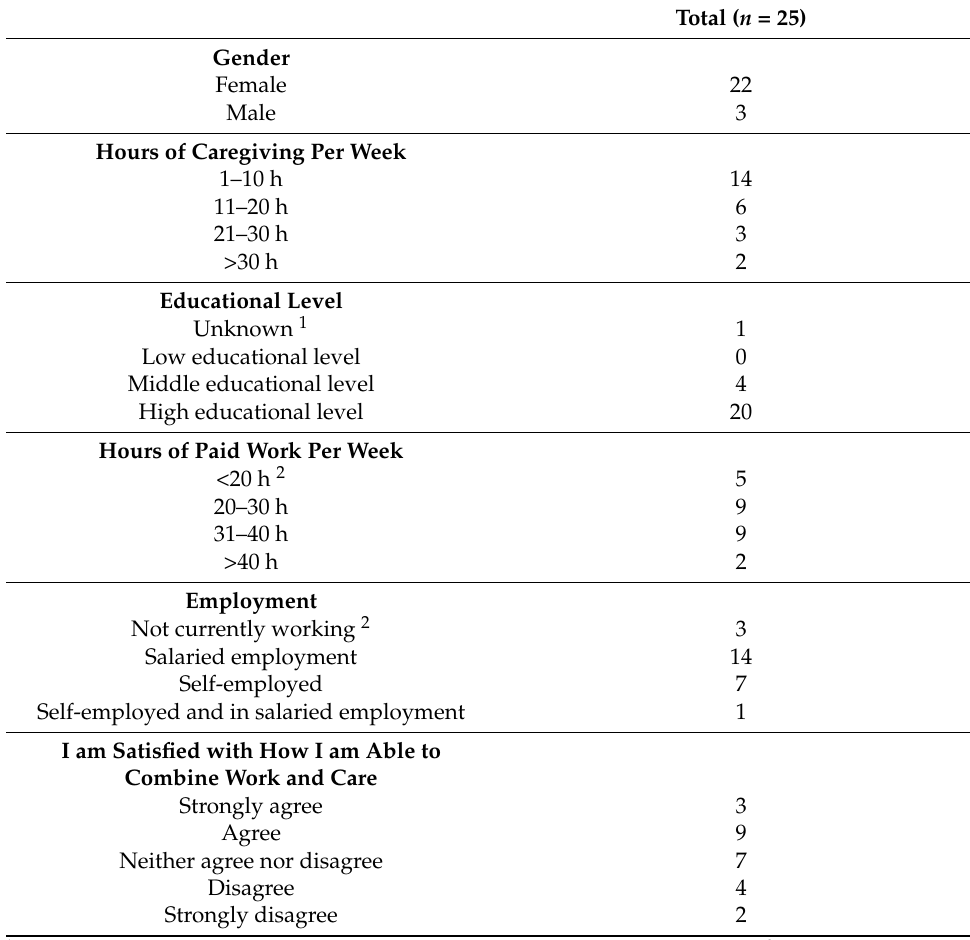
Table 2. Characteristics of caregivers participating in the focus